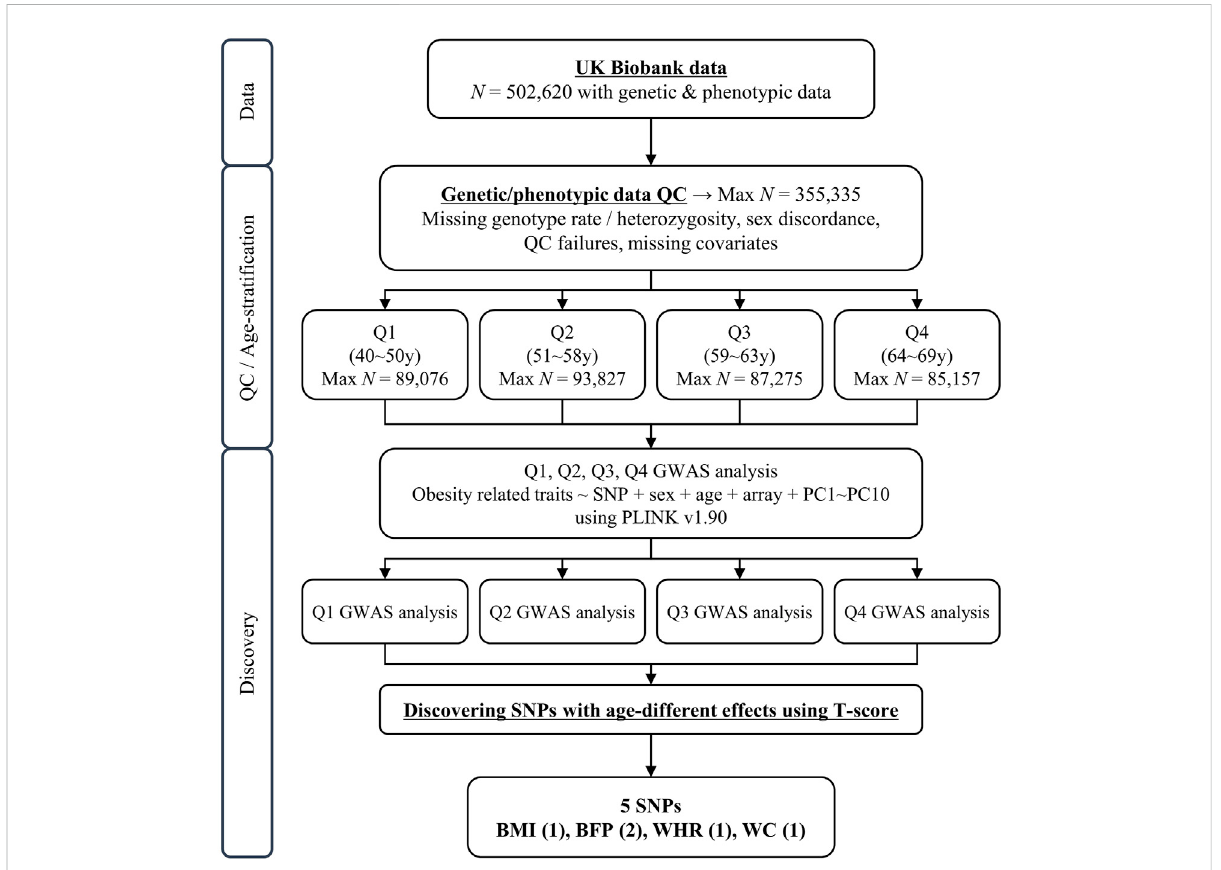
FIGURE 1 Schematic diagram of study design. N, sample size; QC, quality control; GWAS, genome-wide association study; UKB, United Kingom Biobank.